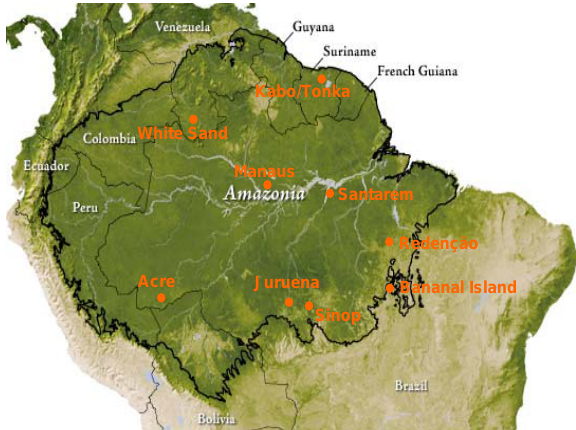
Fig. 9. Sites of detailed validation using water table observations from published literature (base-map: vegetation index from R. Simmon, NASA Earth Observatory).